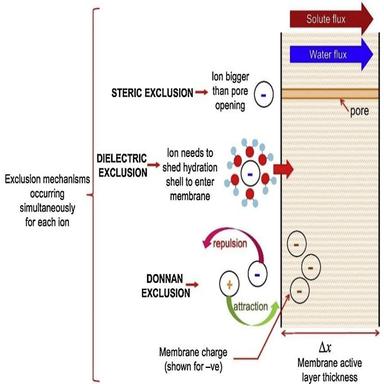
Schematic representation of solute exclusion mechanism in nanofiltration.